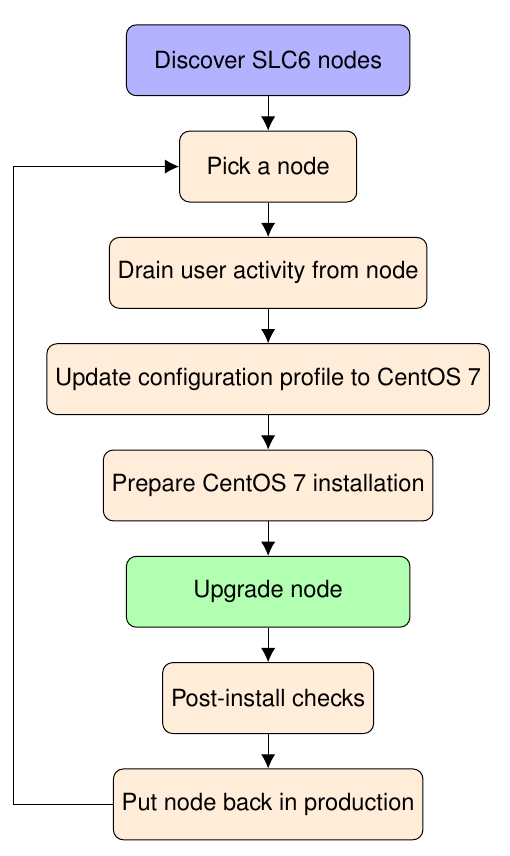
Figure 1. Simplified flowchart of the upgrade